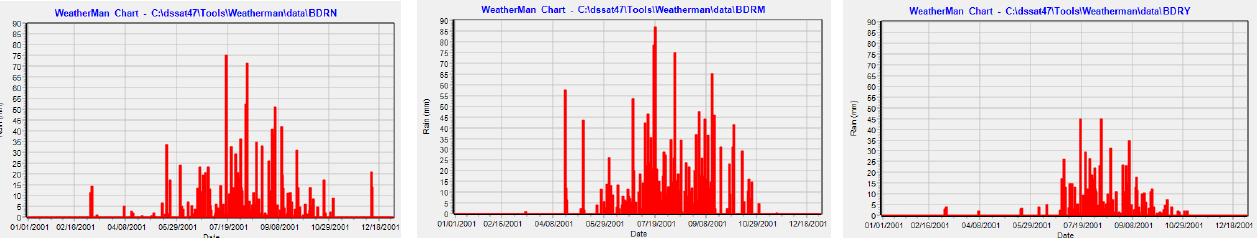
Figure 5. Generated normal, more, and less rainfall patterns for crop simulation.